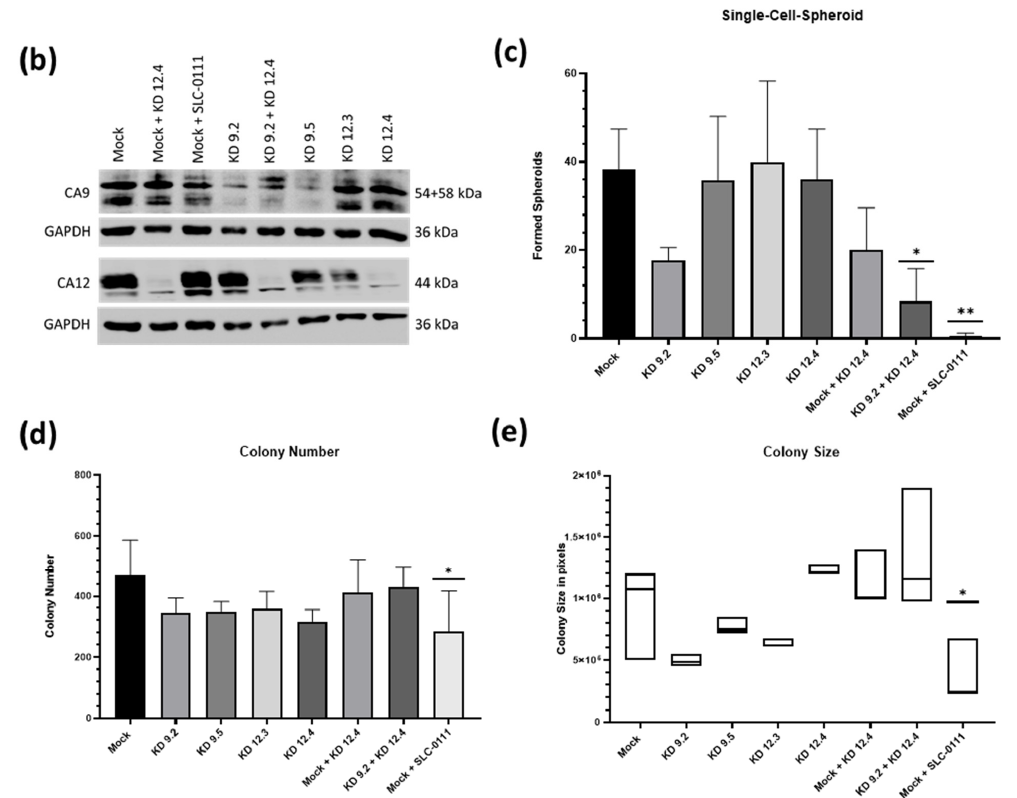
Figure 3. Impact of CAIX/CAXII expression on tumor biological functions of HT29 cells ( a ): im- munocytochemistry of monolayer culture showing ubiquitous expression of both CAIX (left) and CAXII (right) (scale bar: 100 µ m). ( b ): Western blot analyses of CAIX/CAXII expression in mock and knockdown cells. Two different shRNAs were used for each CA. ( c ): Spheroid forming from single- cell level was significantly reduced in cells with the combined CAIX/CAXII knockdown and mock cells treated with SLC-0111 (mean with SD, n ≥ 3). ( d ): Significant reduction in colony number in mock cells treated with SLC-0111 (mean with SD, n ≥ 3). ( e ): Significant reduction in colony size in mock cells treated with SLC-0111 (median with range, n ≥ 3). The clonogenicity assay and single- cell spheroid assay were repeated three or more times per condition in separate trials. (*: p ≤ 0.05, **: p ≤ 0.01.)